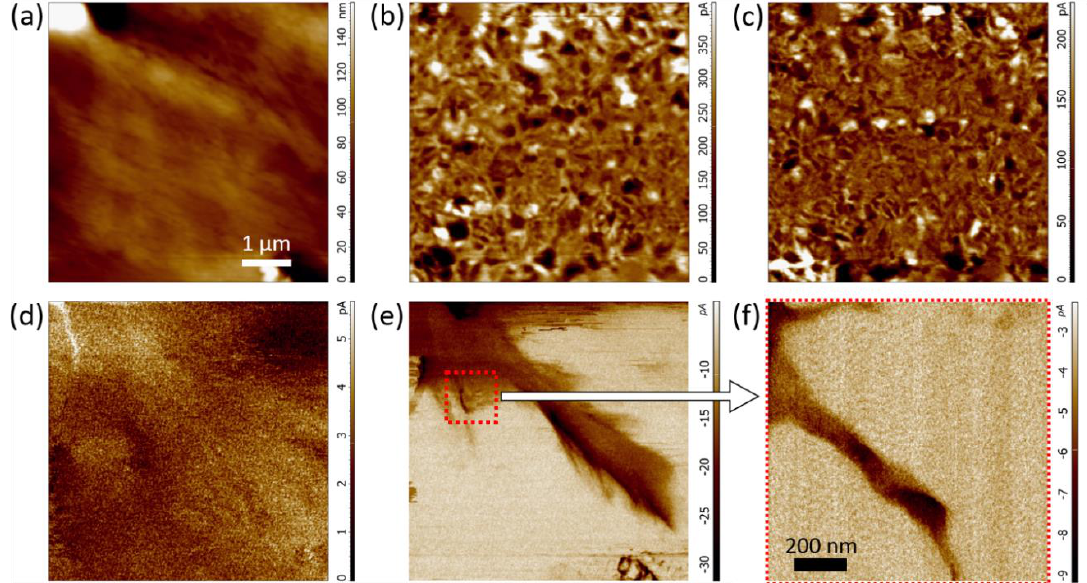
Figure 3. SPM measurements of the Bi 0.95 Ca 0.05 Fe 0.9 Ti 0.1 O 3.025 sample: ( a ) surface topography, ( b ) OOP PFM response, ( c ) IP PFM response, ( d ) c-AFM response at positive DC bias voltage of 10 V, ( e ) c-AFM response at negative DC bias voltage of −10 V, ( f ) magnified c-AFM image of the area marked by the red dotted square in ( e ).